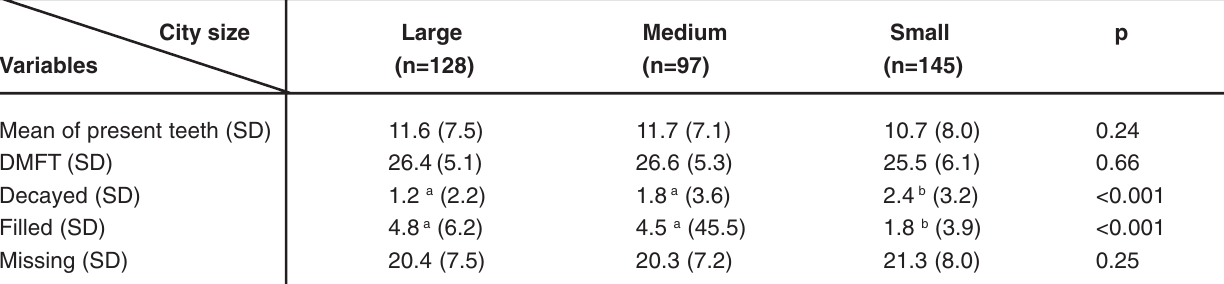
TABLE 4- Mean of present teeth and dental caries experience in dentate individuals according to city size. Southern Region of the state of São Paulo